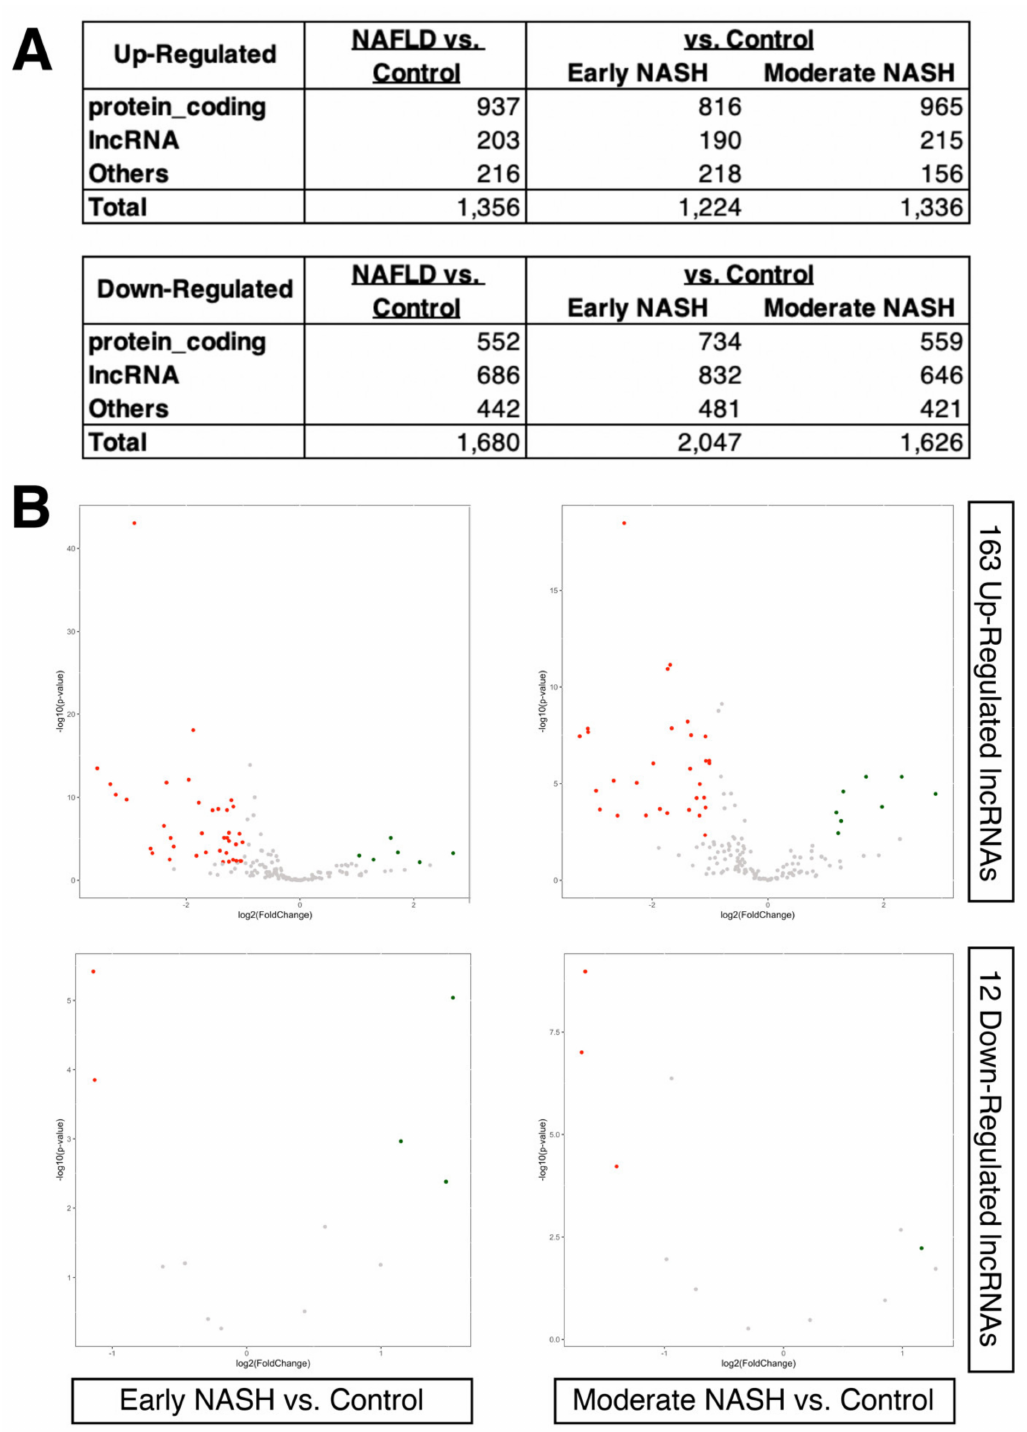
Figure 2. Gene expression changes in different stages of NASH compared to obese